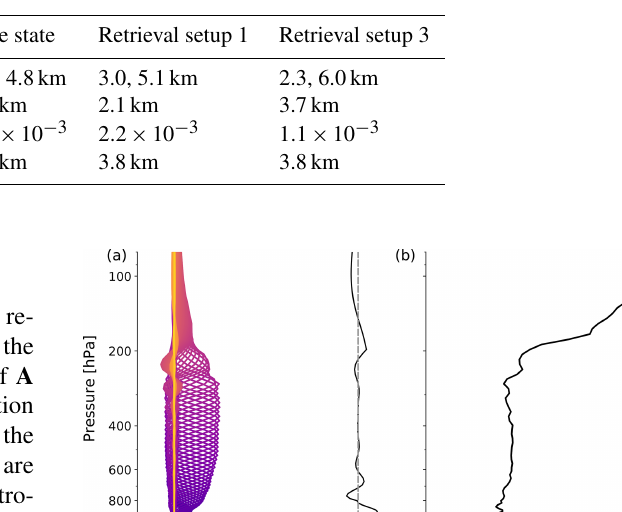
Table 2. Moisture anomaly characteristics of the EML shown in Fig. 4. This table is analogous to Table 1, where the exact definitions of the different metrics are explained. The EML characteristics displayed here are calculated for the true state and the retrieval results of retrieval setups 1 and 3, corresponding to upper and lower rows of Fig. 4, respectively. Retrieval setup 2 does not feature a moisture anomaly object as defined in Sect. 3.